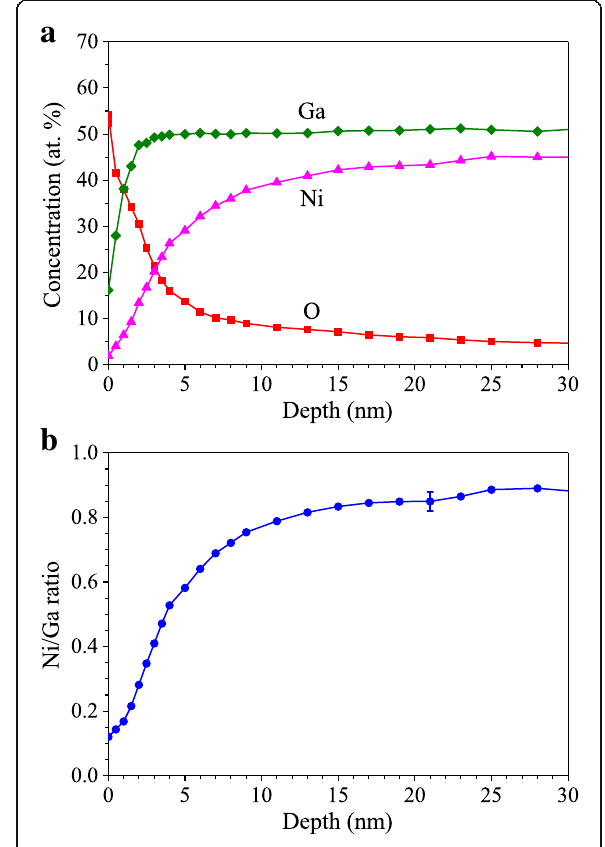
Fig. 5 a XPS elemental concentration depth profile (in at. %) at 25 °C of the Ga 3 Ni 2 single crystal that was oxidized due to contact with air. b The corresponding depth profile of the Ni/Ga concentration